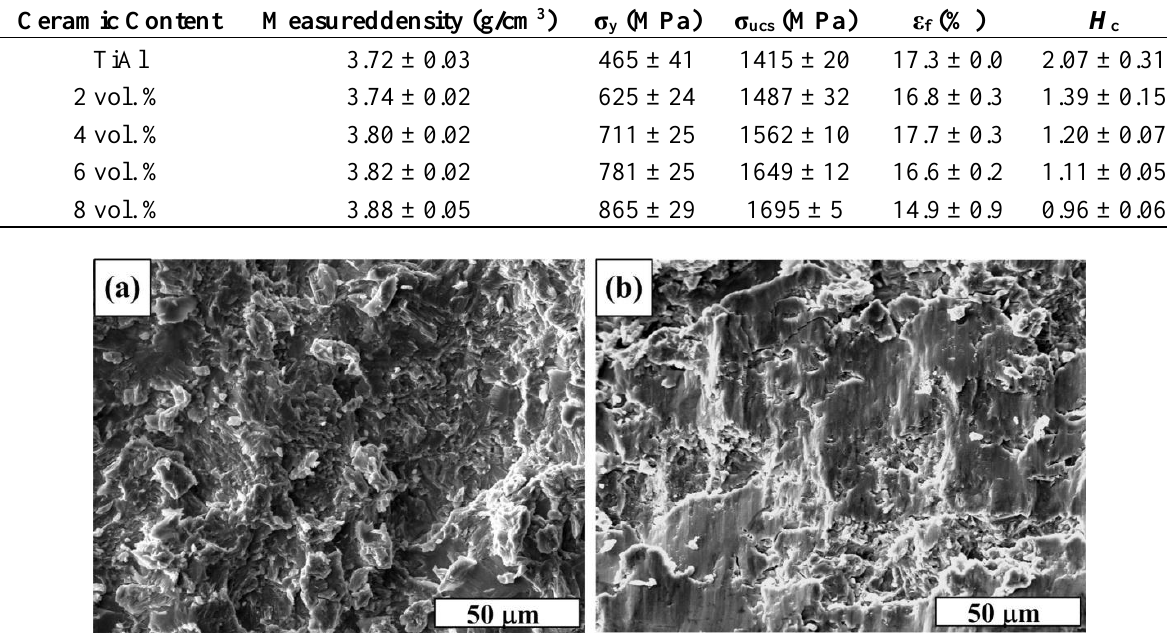
Figure 3. True compression stress-strain curves of TiAl alloy and the in situ dual reinforcement TiB 2 -Ti 2 AlC/TiAl composites fabricated by using the Ti-Al-B 4 C system. Table 1. Compression properties and work-hardening capacity ( H c ) of TiAl alloy and the in situ dual reinforcement TiB 2 -Ti 2 AlC/TiAl composites fabricated by using the Ti-Al-B 4 C system.